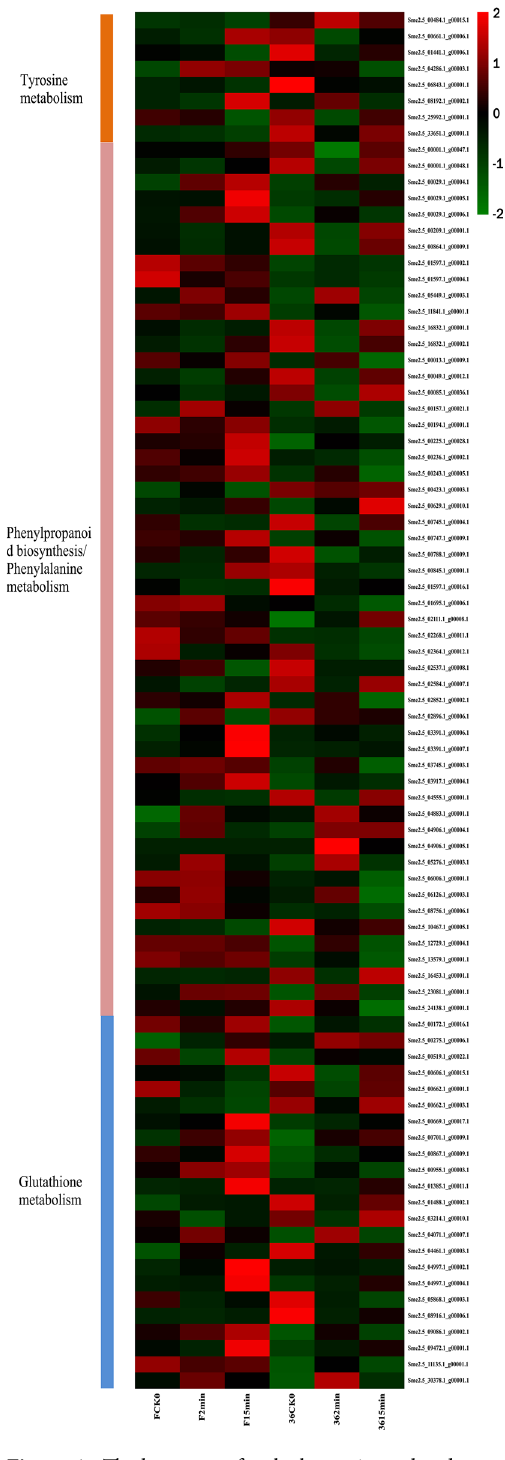
Figure 6. The heat maps for the browning-related genes. The red color in the picture indicates high expression genes, while the green color indicates low expression genes. The heat map was drawn with pheamap (v1.0.12) (Kolde, R. pheatmap: Pretty Heatmaps, r package version 1.0.12 (2019). https:// CRAN.R- proje ct. org/ packa ge= pheat